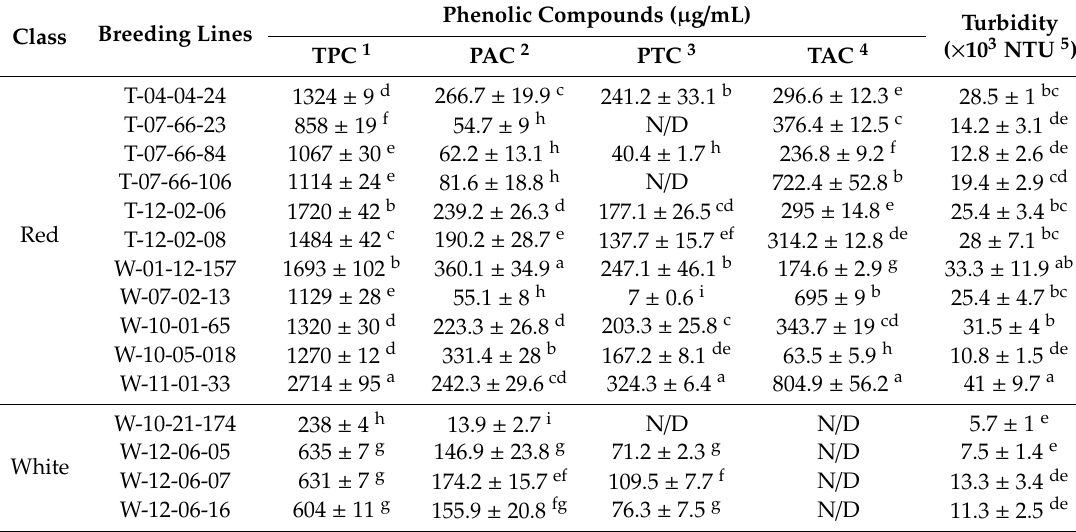
Table 3. Concentrations of phenolic compounds in wines made from di ff erent breeding lines.